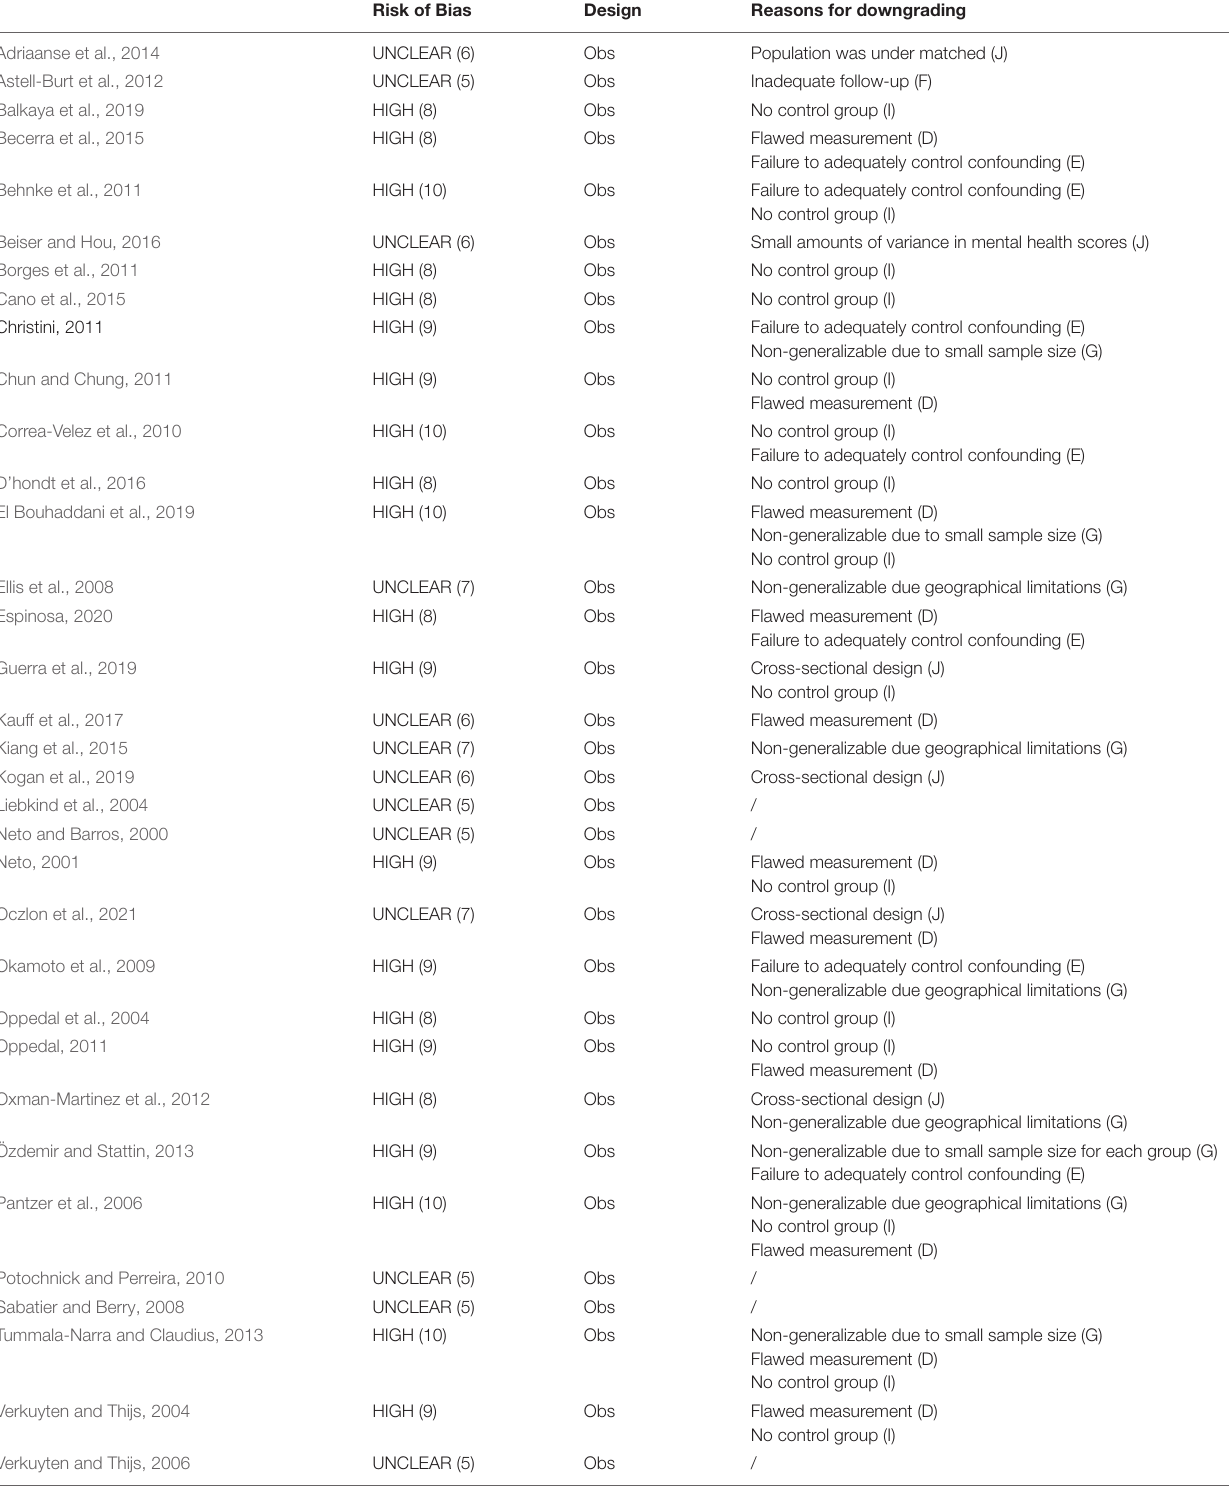
TABLE 4 | Risk of Bias assessment for included studies based on GRADE assessment ( k =